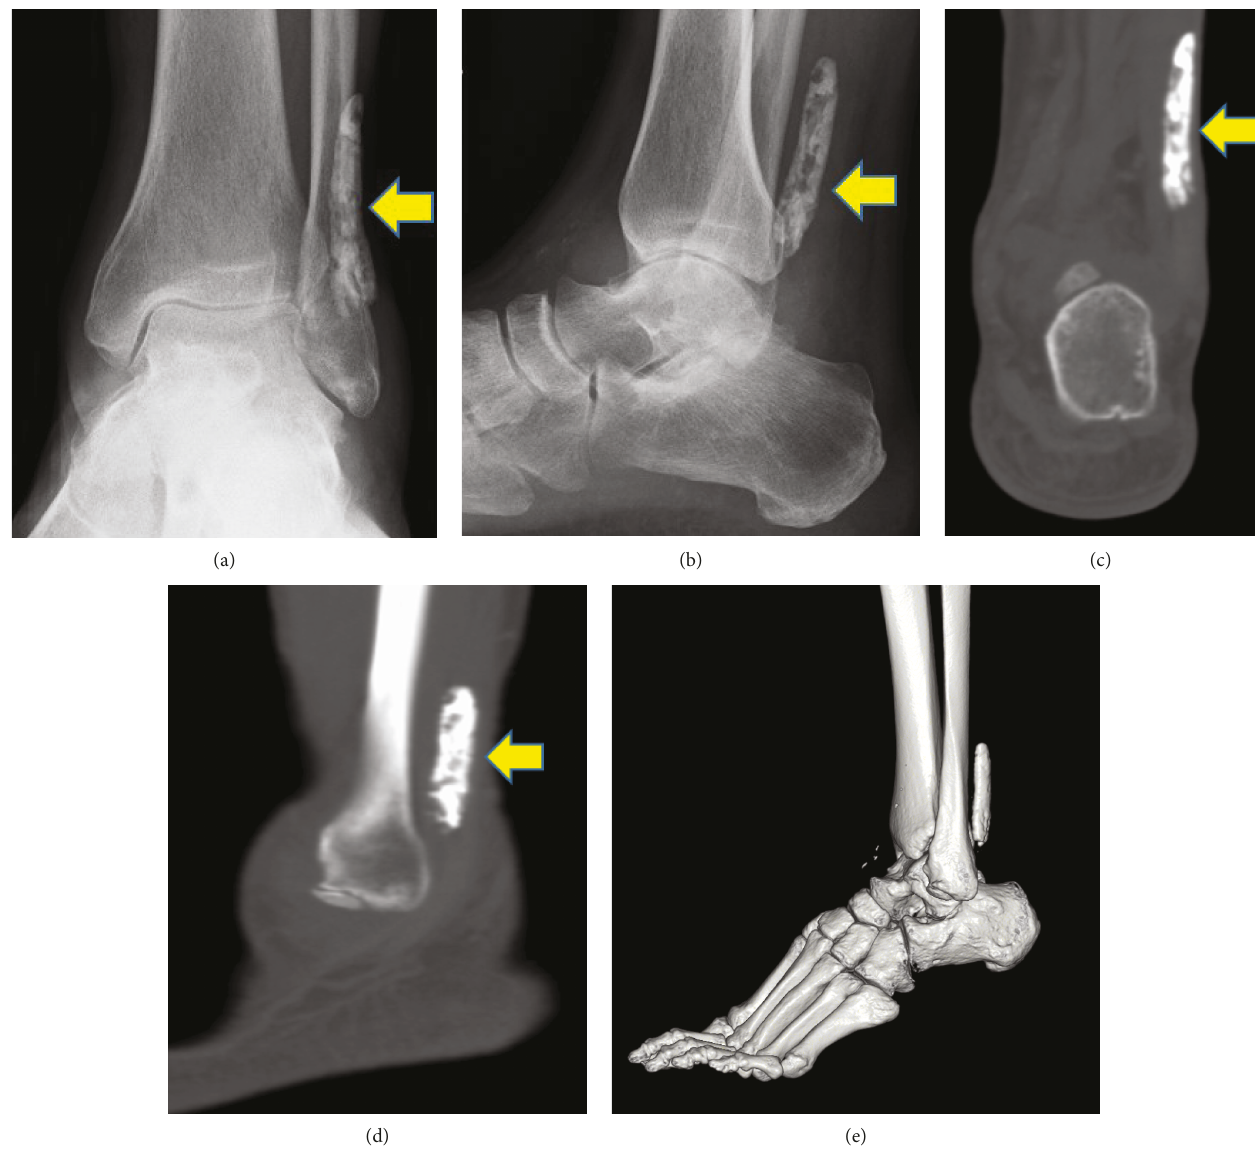
Figure 2: X-ray and CT showed a 1 × 5cm elliptical opaci fi cation (yellow arrow) along the course of the peroneal tendon. (a) AP view of the X-ray image. (b) Lateral view of the X-ray image. (c) Coronal section of the CT image. (d) Axial section of the CT image. (e) 3D reconstruction of the CT